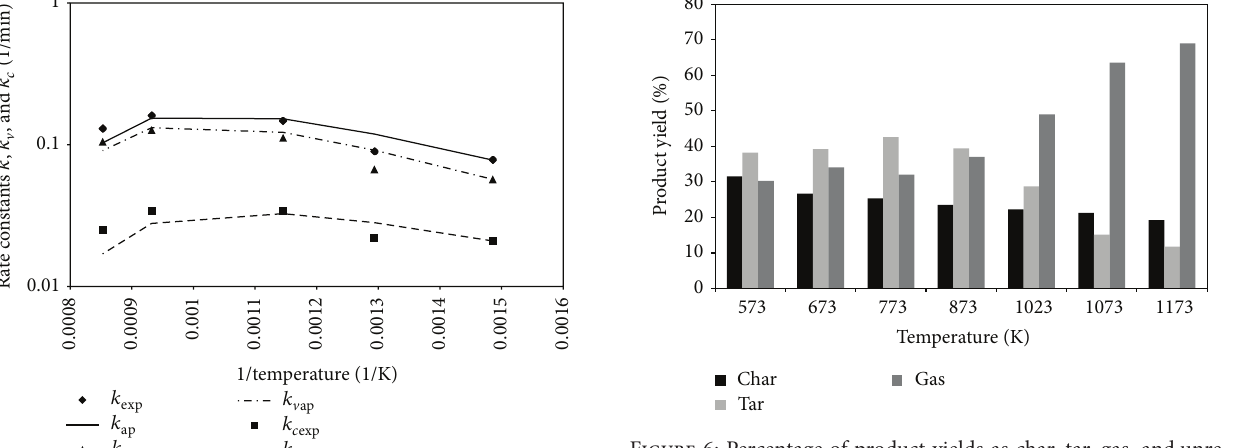
Figure 6: Percentage of product yields as char, tar, gas, and unre- acted reactant in different pyrolysis temperature (K). , 𝑘 V , and app app 𝑘 exp ,